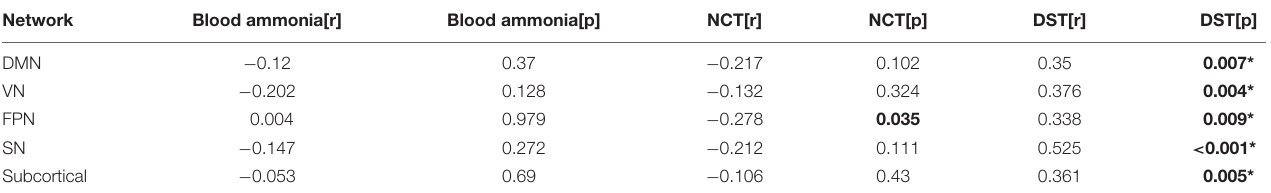
TABLE 4 | Networks showing significant correlation of connection-stability with clinical test scores.